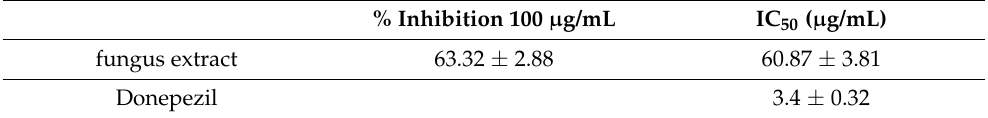
Table 4. Inhibitory effect of P. chysogenum MZ945518 extract on acetylcholine esterase activity.